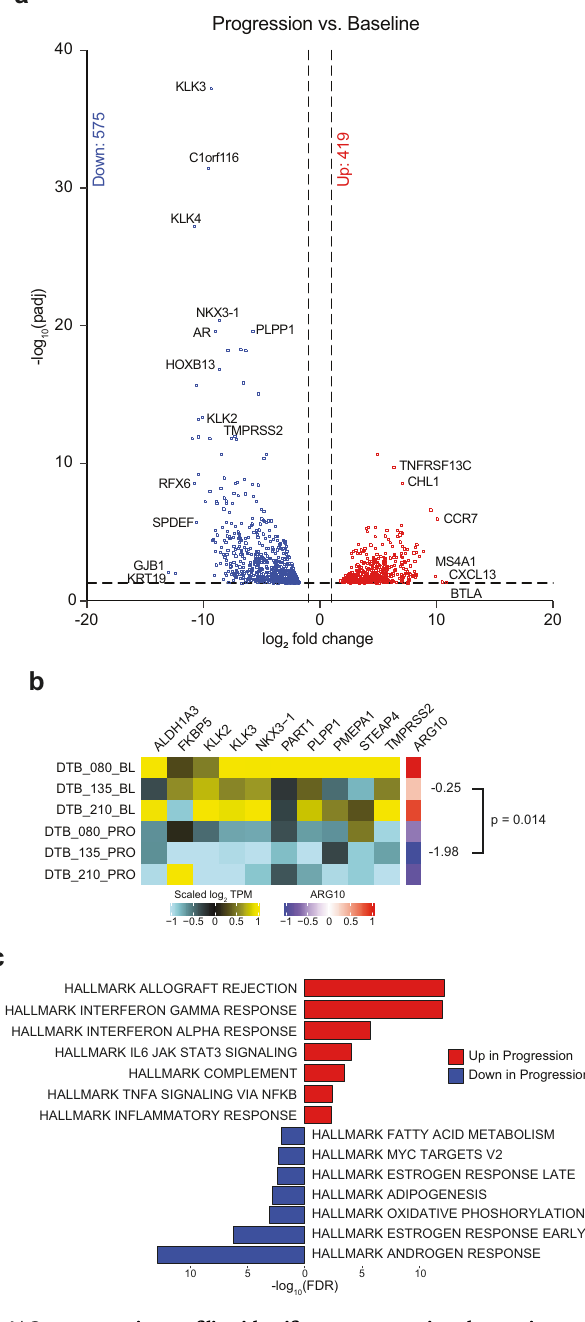
Fig.4 |Geneexpressionpro fi lingidenti fi esgeneexpressionchangesintumors undergoing enzalutamide-induced lineage plasticity. a Volcano plot showing top up and down regulated genes in progression samples vs. baseline samples for the three patients whose tumors converted ( n =3 pairs, no replicates). Adjusted p-values were calculated using the Wald test in the DESeq2 R package 55 . b ARG10 gene signature heatmap for three converters at baseline and progression. Theleftshowstheexpressionlevelsofindividualgenesinthe ARG10 signature, and the right shows the ARG10 signature score. p-value shown is for a two-tailed paired t-test between baseline and progression ARG10scores( n = 3pairs,noreplicates). c Hallmarkpathwayanalysisshowsthe top up or down regulated pathways in progression vs. baseline samples for the three patients whose tumors converted. Source data are provided as a Source Data fi